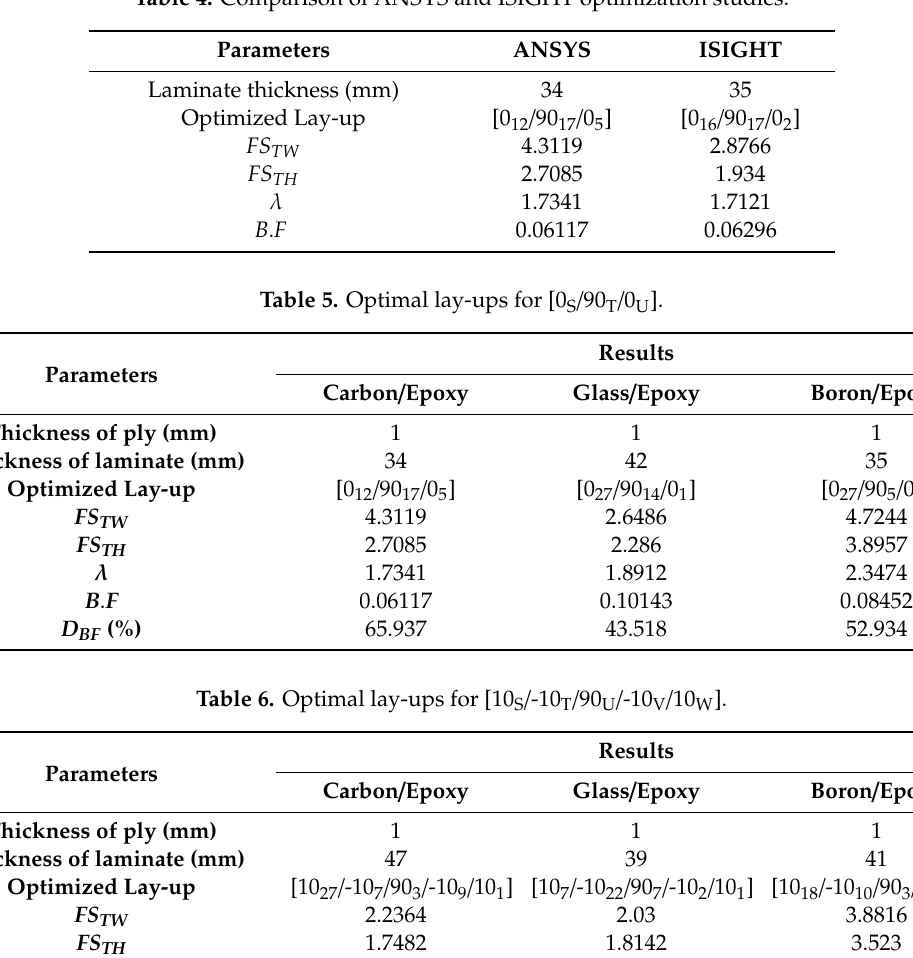
Table 4. Comparison of ANSYS and ISIGHT optimization studies.